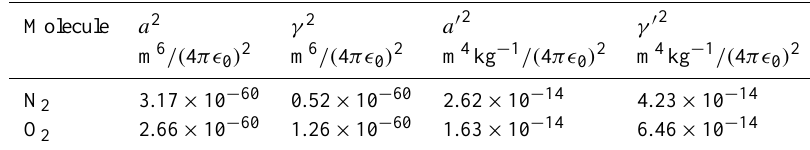
Table 3. Averaged polarizability a,a (cid:48) and anisotropy γ,γ (cid:48) according to Weitkamp (2005) and references therein for incident wavelengths between 400 and 500nm. The resulting differential cross-sections d σ/ d (cid:127) are listed in Table 9.